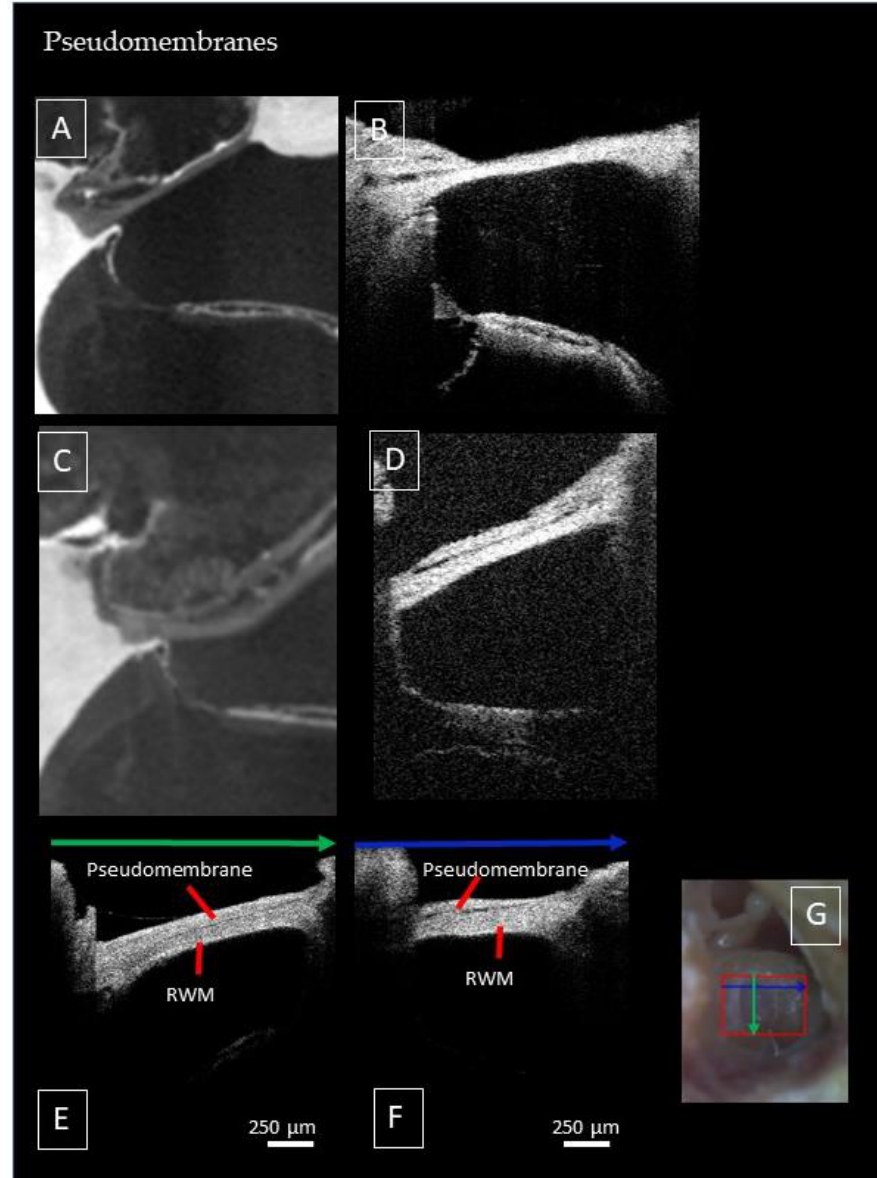
Figure A4. This supplementary Figure illustrates the presence of a pseudomembrane. Figure ( A ) is a microCT image of the same sample as in Figure ( B ), and Figure ( C ) corresponds to Figure ( D ). Figure ( E ) shows a cross-section in the x-direction, indicated by the green arrow on top of the figure and in the microscopic image in Figure ( G ). Figure ( F ) is a cross-section in the y-direction, indicated by the blue arrow on top of the image and in the corresponding microscopic image ( G ). The pseudomembrane is visible as a thin black gap between the pseudomembrane and the RWM. A-scan rates for OCT images ( B – F ) are respectively 10 kHz, 76 kHz, 28 kHz, and 28 kHz.